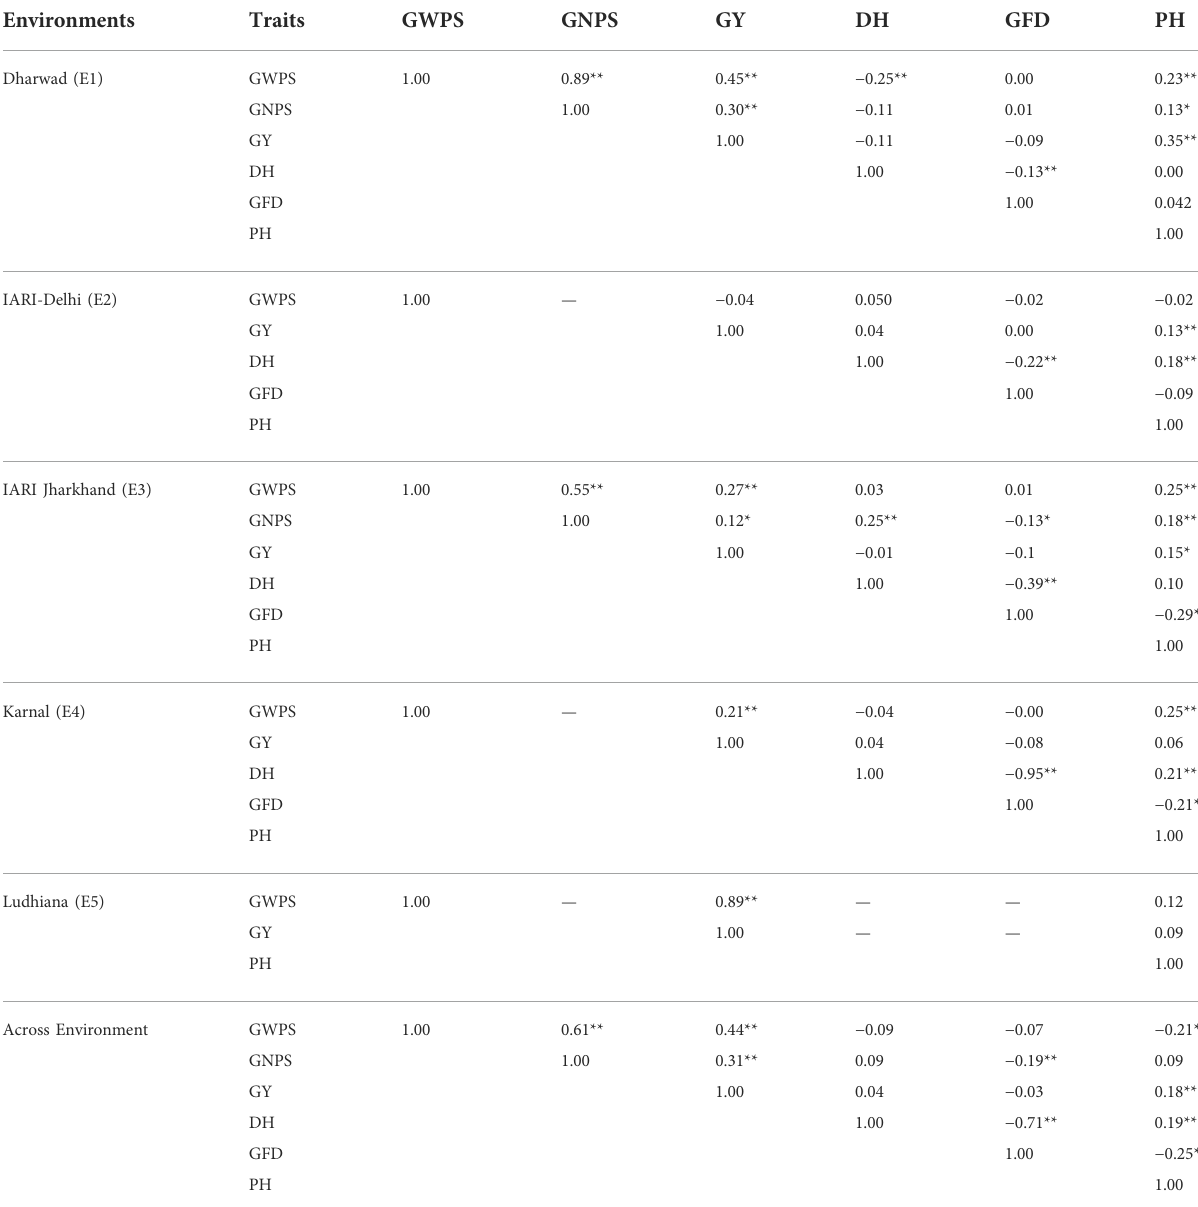
TABLE 2 Estimates of phenotypic correlation coef fi cients for grain yield and component traits in GWAS panel evaluated at Dharwad, IARI Delhi, IARI Jharkhand, Karnal, and Ludhiana during 2020 – 2021. Environments Traits GWPS GNPS GY DH GFD